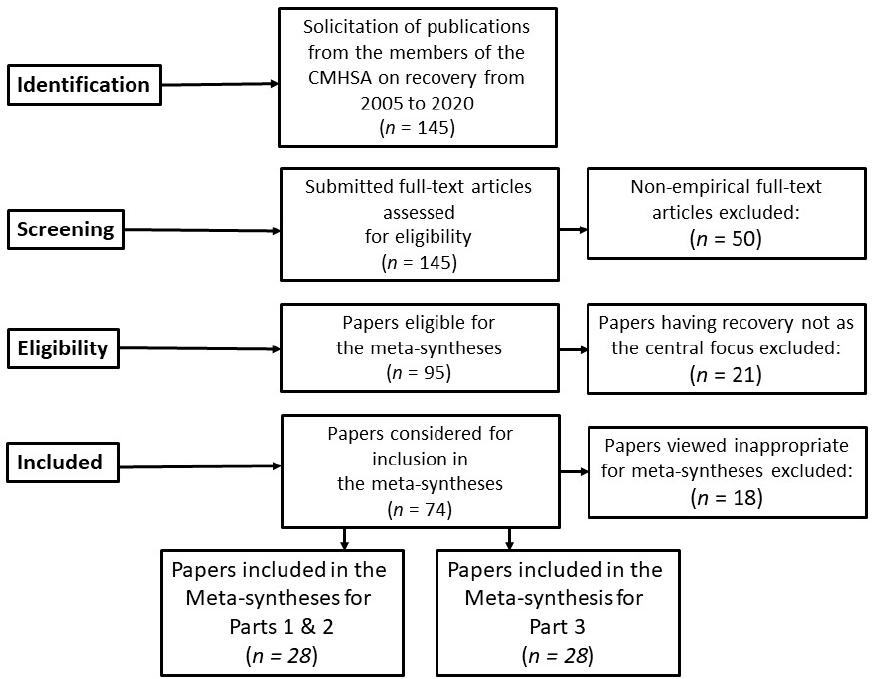
Figure 1. The steps taken by the research team for the meta-syntheses for Parts 1, 2, and 3.